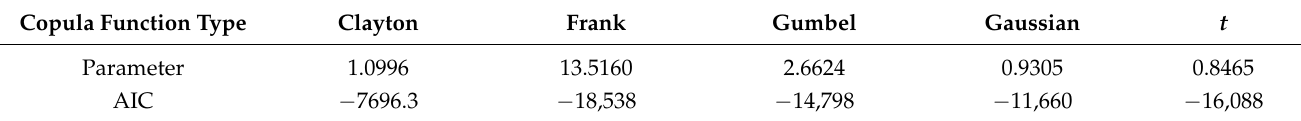
Table 2. Parameters and AIC values of different copula functions for Machine pair 5–6.